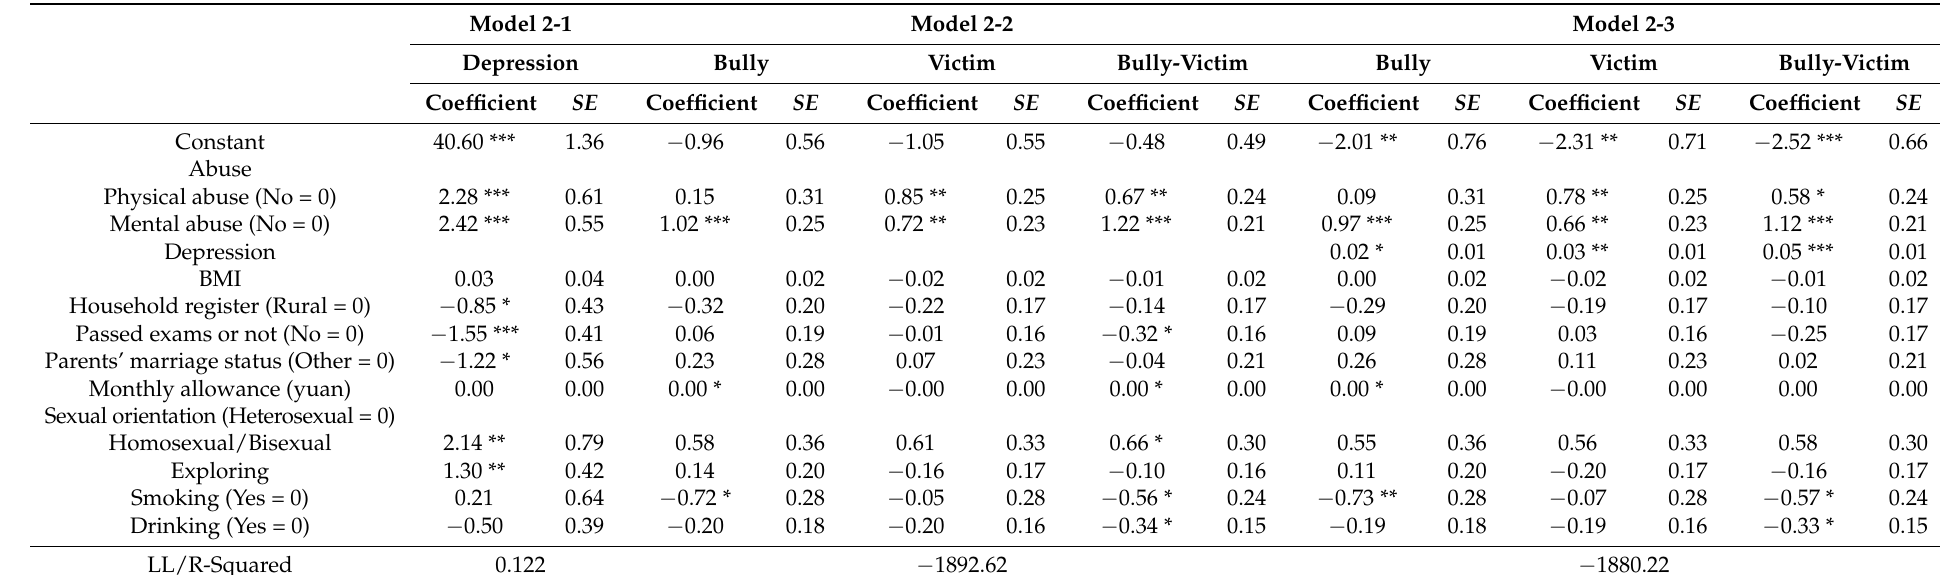
Table 2. Logit and OLS Regression Predicting Category of Bully Status and Depression for Males (n = 1584). Model 2-1 Model 2-2 Model 2-3 Depression Bully Victim Bully-Victim Bully Victim